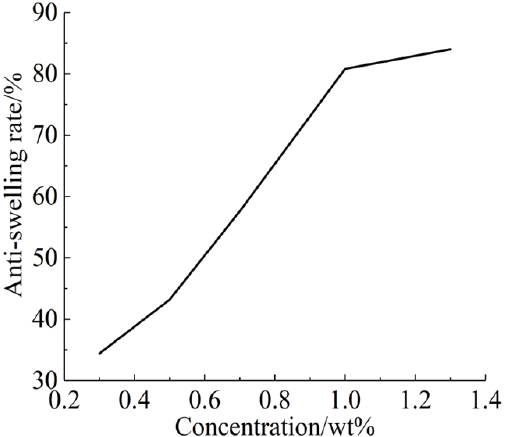
Figure 8. The anti–swelling performance of potassium chloride solution.